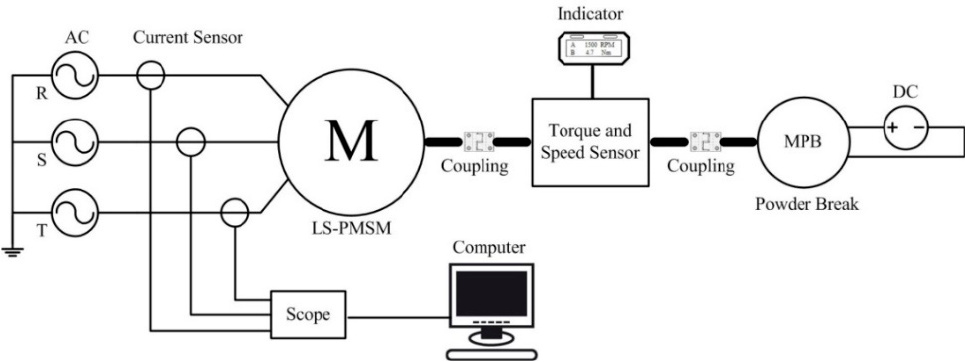
Figure 9. Schematic diagram of the experimental test setup.